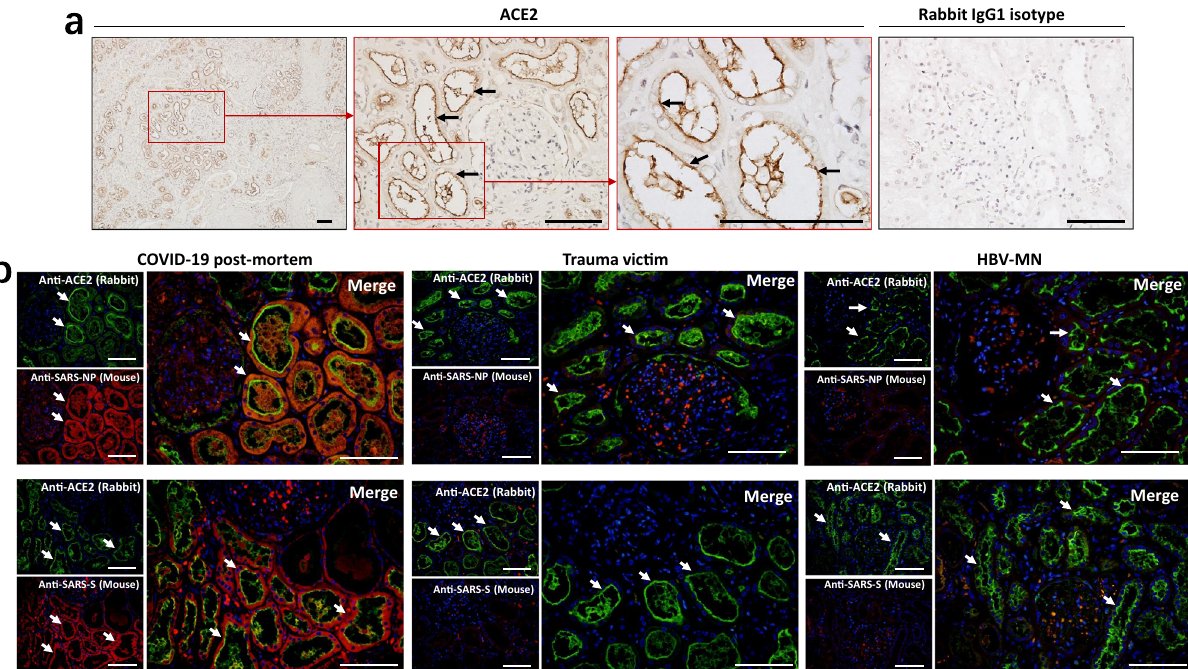
Fig. 3 SARS-CoV-2 protein antigens co-express with ACE2 in kidney tubules. a Representative expression of angiotensin-converting enzyme-II (ACE2) in kidney tissues from COVID-19 post-mortem (case #2) was detected by immunohistochemistry. Scale bars = 100 μ m. b The co-expression of ACE2 and SARS-CoV-2 NP (nucleocapsid protein) or S (spike) antigens in kidney sections from COVID-19 post-mortem (case #2), hepatitis B virus-associated membranous nephropathy (HBV-MN) and trauma victims. Arrow indicates positive tubules. Scale bars = 100 μ m. Data represent one of at least three technical replication